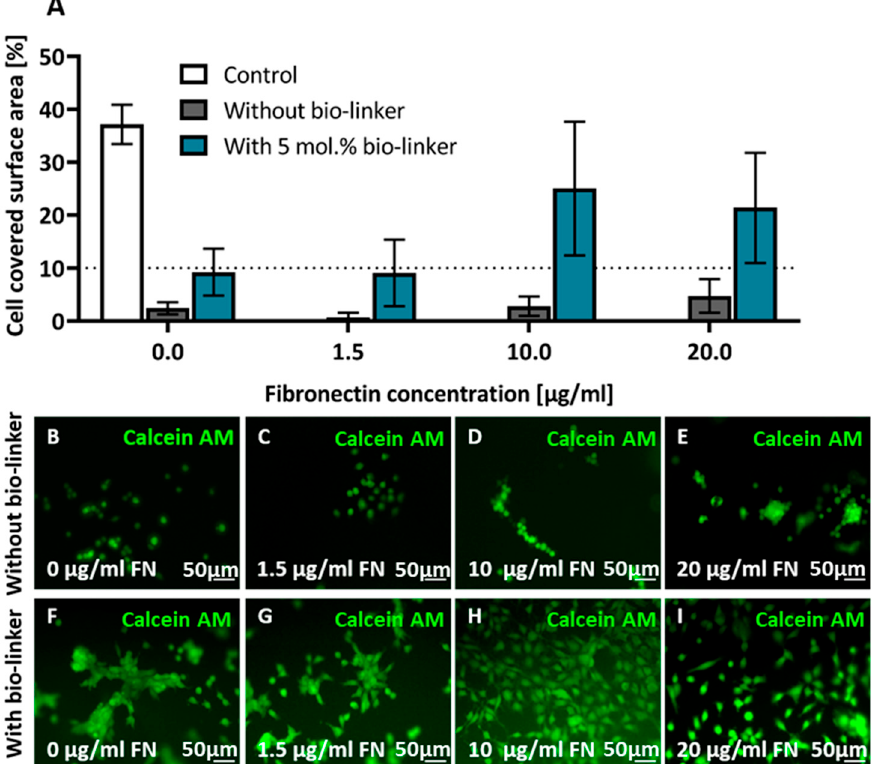
Figure 3. ( A ) Cell surface coverage determined from calcein AM fluorescence of fibroblast cells after 24 h incubation on pHEMA hydrogels (1 wt.% crosslinker, without (grey) and with bio-linker ( 3 ) (blue)) as a function of fibronectin concentration, compared to a control sample (petri dish). Increasing fibronectin concentration leads to an increase of cell coverage (data: mean ± standard deviation).